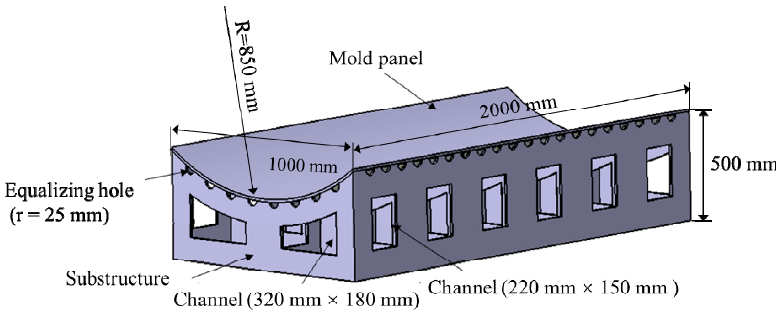
Figure 6. Simplified mold model.